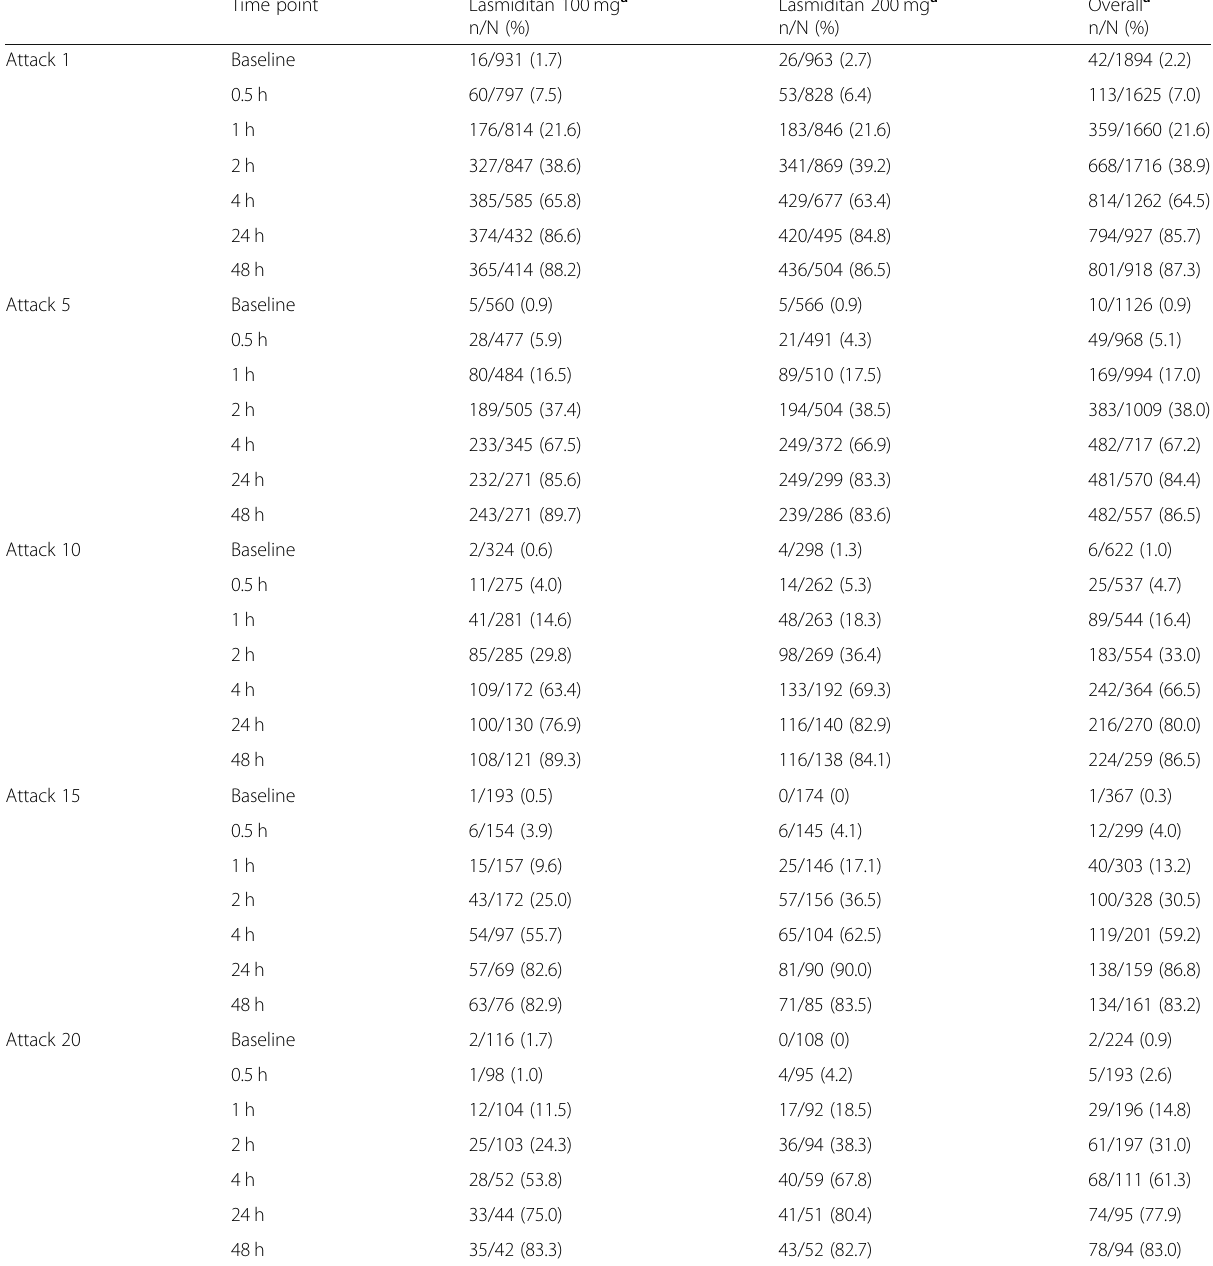
Table 4 Observed case analysis of patients free of disability at specified times post-dose for selected